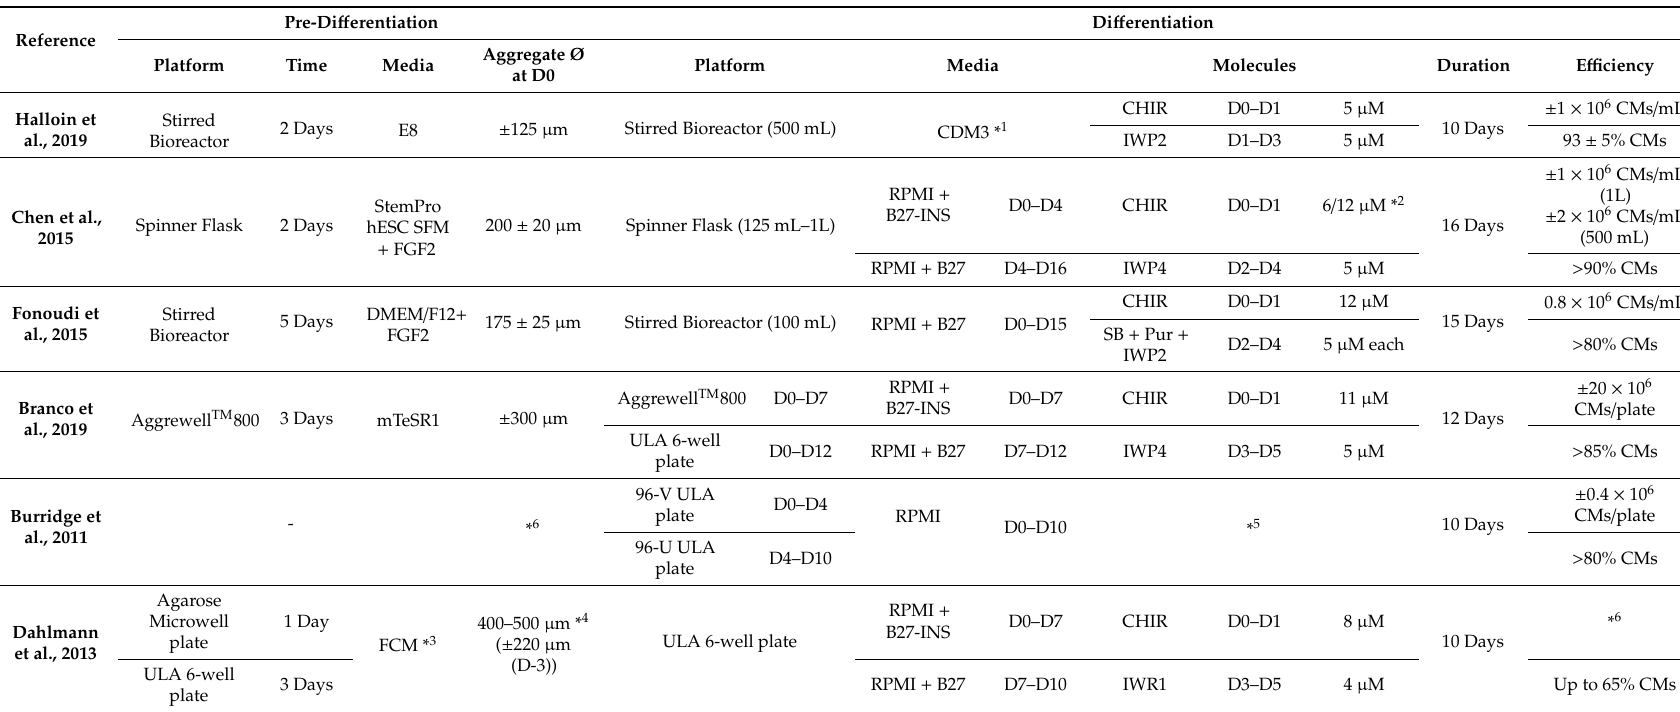
Table 1. Summary of studies reporting CM di ff erentiation from hPSCs under 3D conditions. The table highlights 3D-CM di ff erentiation platforms in dynamic systems (bioreactors and spinner flasks) and static conditions (microwell plates and ULA attachment plates). Ø, diameter; ULA, Ultra Low Attachment Plate.